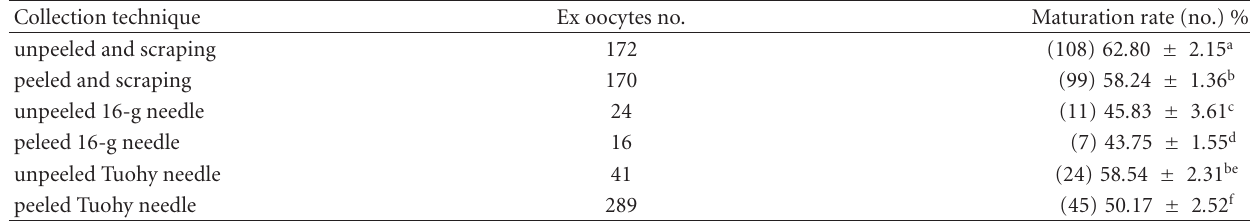
Table 3: Maturation